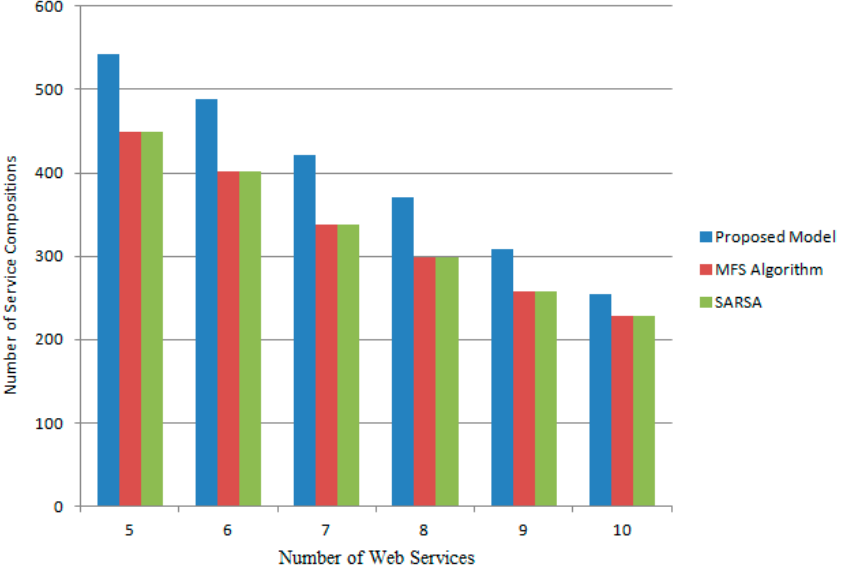
Figure 6. Number of constructed service compositions when the composition threshold = 200.